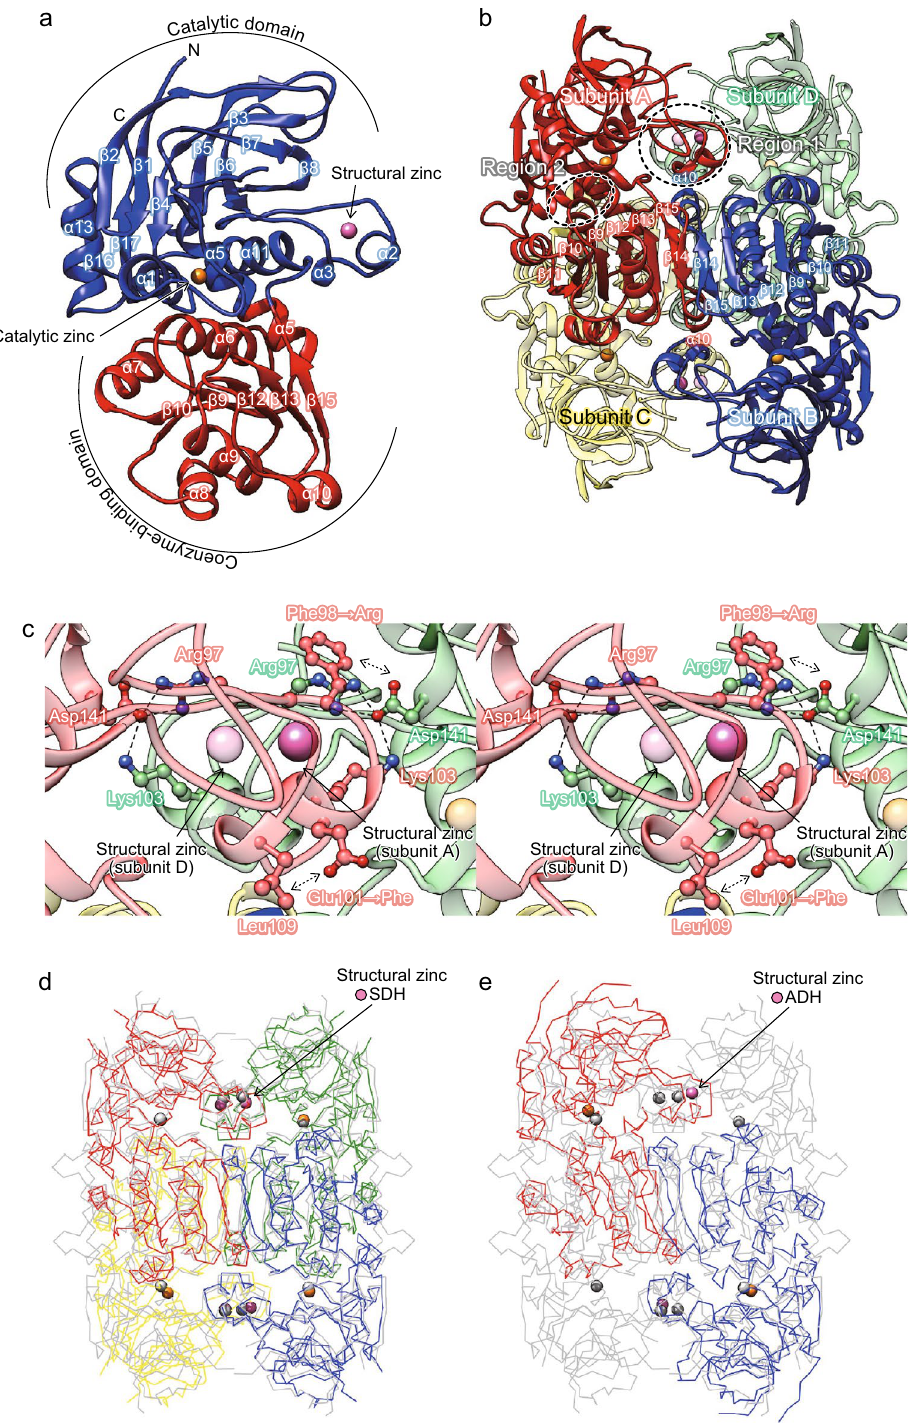
Figure 3. Crystal structure of the PsXDH C4 mutant. ( a ) Monomer structure. The catalytic domain housing both catalytic and structural zinc atom (orange and magenta spheres, respectively) is shown in blue, and the cofactor-binding domain is shown in red. The figure was prepared using PyMOL 49 . ( b ) Structure of the biological tetramer generated from crystallographic symmetry. The tetramer is a dimer of dimers (A/B and C/D). The dashed line ellipse indicates two contact regions 1 ( c ) and 2 between two dimers. In ( c ), hydrogen bonds are shown as black dashed lines. It is likely that the mutated Arg98 in subunit A can form a salt bridge with Asp141 in subunit D of another dimer, and the mutated Phe101 interacts with Leu109 within the same loop hydrophobically. Superimposed Cα traces of the structures of tetrameric PsXDH C4 (gray) on tetrameric SDH from silverleaf whitefly (1E3J) ( d ) and dimeric ADH from Arabidopsis thaliana (2CF5) ( e